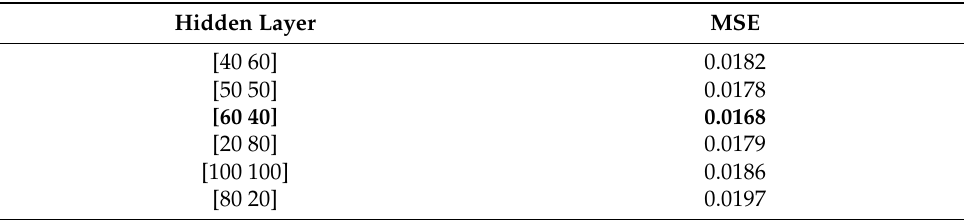
Table 3. MSE of the neural network with two hidden layers.